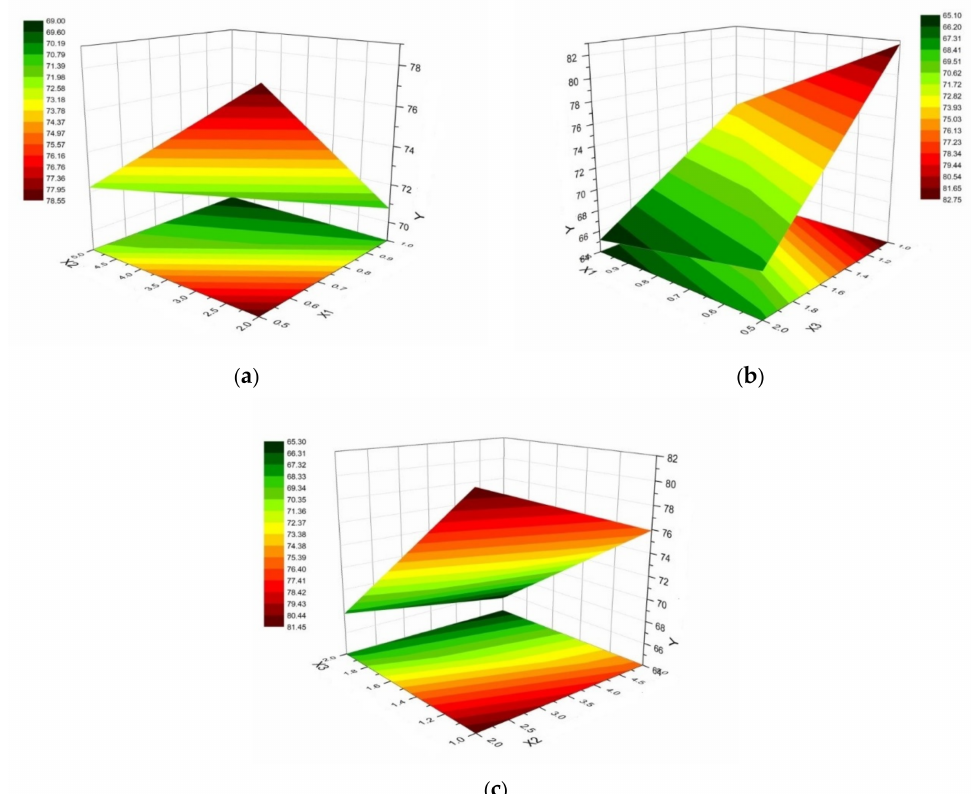
Figure 10. Highlighting in 3D the evolution of the Y parameter (percentage of bupivacaine hydrochlo- ride) according to the formulation variables ( a ) X 1 (chitosan concentration) and X 2 (HPMC E 5 LV concentration); ( b ) X 1 (chitosan concentration) and X 3 (chitosan/HPMC E 5 LV ratio); and ( c ) X 2 (HPMC E 5 LV concentration) and X 3 (chitosan/HPMC E 5 LV